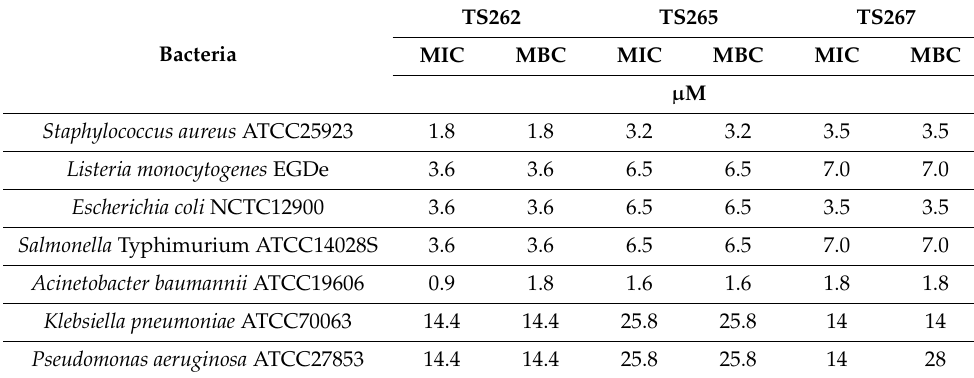
Antibacterial activity of metallic compounds against a range of Gram-positive and -negative